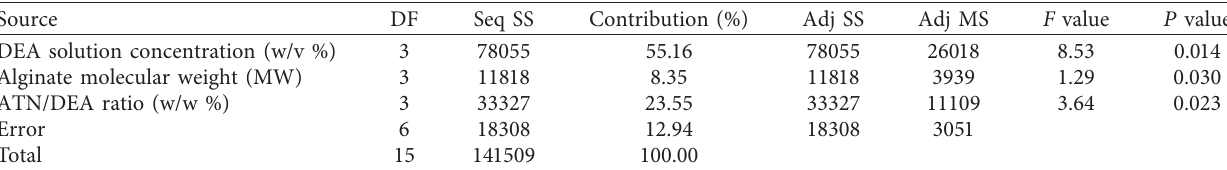
Figure 3: Probability plot for particle Table 5: Analysis of variance for particle size.